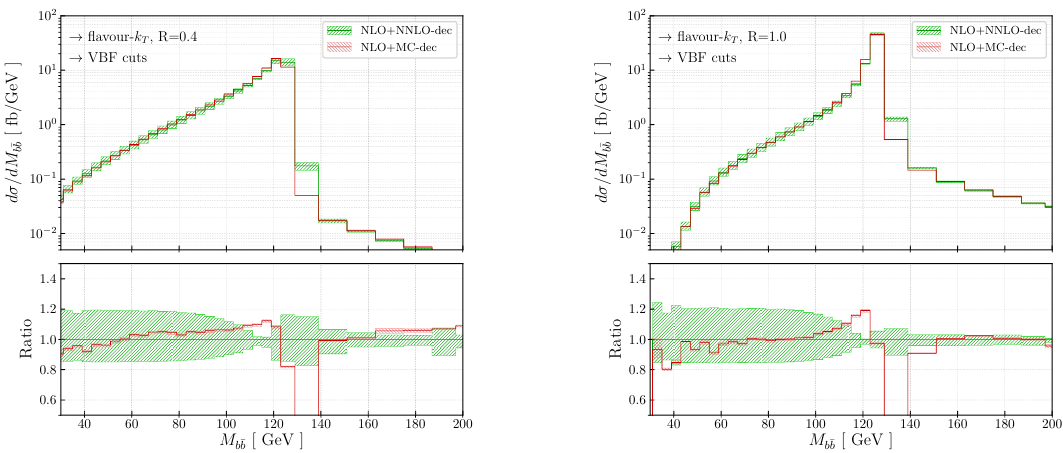
Figure 5 . Invariant mass of the two b -jets in VBF Higgs events with Higgs decaying to b -quarks. The VBF cuts described in the text are applied. The jets are reconstructed with the (cid:13)avour algorithm of ref. [52] for R = 0 : 4 (left) and R = 1 : 0